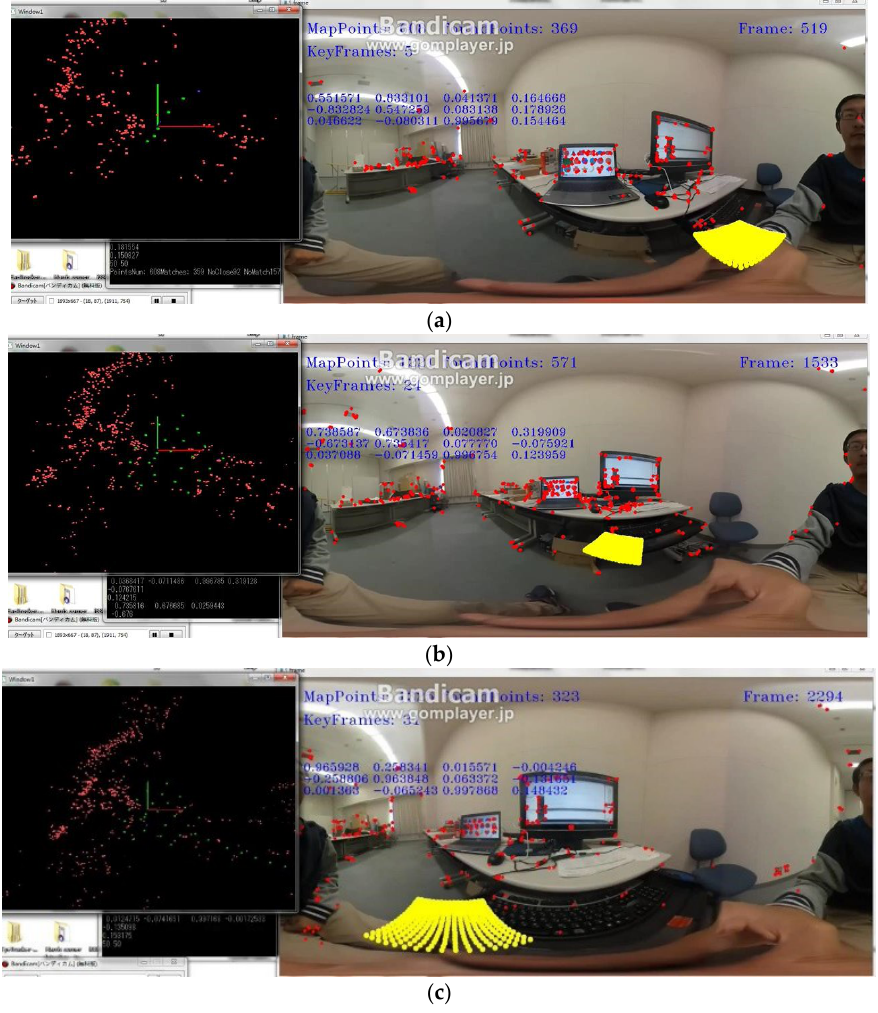
Figure 5. Sample frames from the desk video. ( a ) Frame 519; ( b ) Frame 1533; ( c ) Frame 2294.